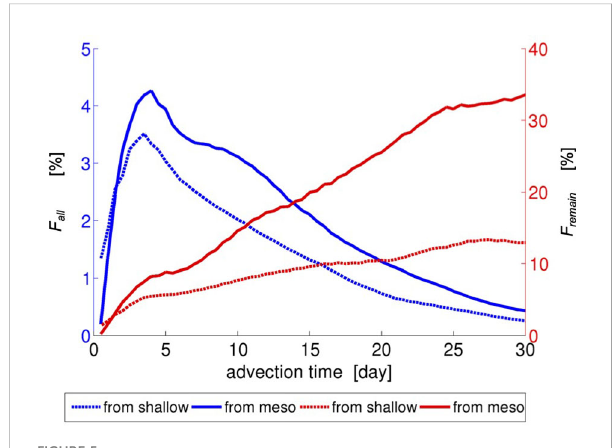
FIGURE 5 Fractions (%) of the virtual larvae transported from the northeastern side of the Motobu Peninsula (areas s4 – s6 and m4 – m5) to the other side (area A in Figure 6C) as a function of the advection time. F all (blue curves): fractions of all the released larvae. F remain (red curves): fractions of the larvae that remain in the study area (viz., those that have not exited). The dotted curves pertain to Case 1 (shallow release) and the solid curves pertain to Case 2 (mesophotic release).